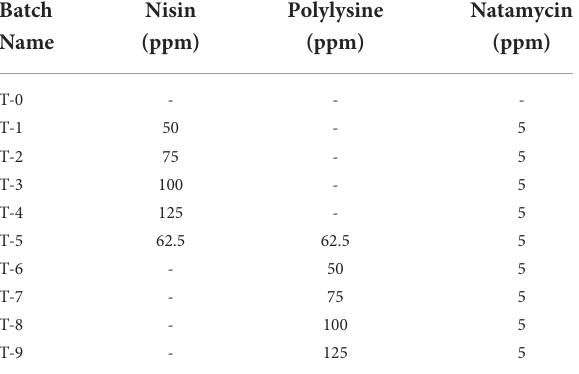
TABLE 1 Treatmentdetails of different combinations of bio-preservatives and their concentration.